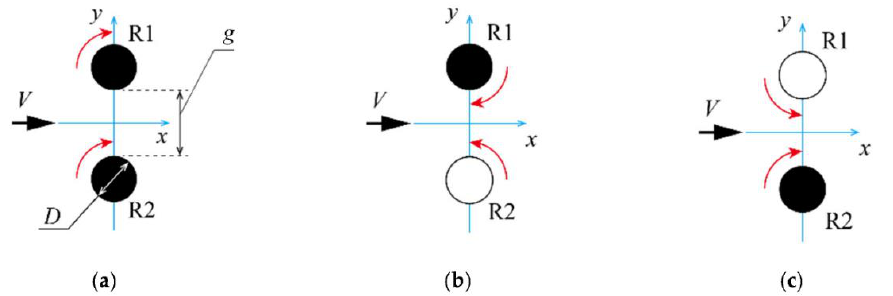
Figure 2. Three layouts against the wind direction in a closely spaced VAWT pair: ( a ) Co-Rotating (CO); ( b ) Counter-Up (CU); ( c ) Counter-Down (CD).